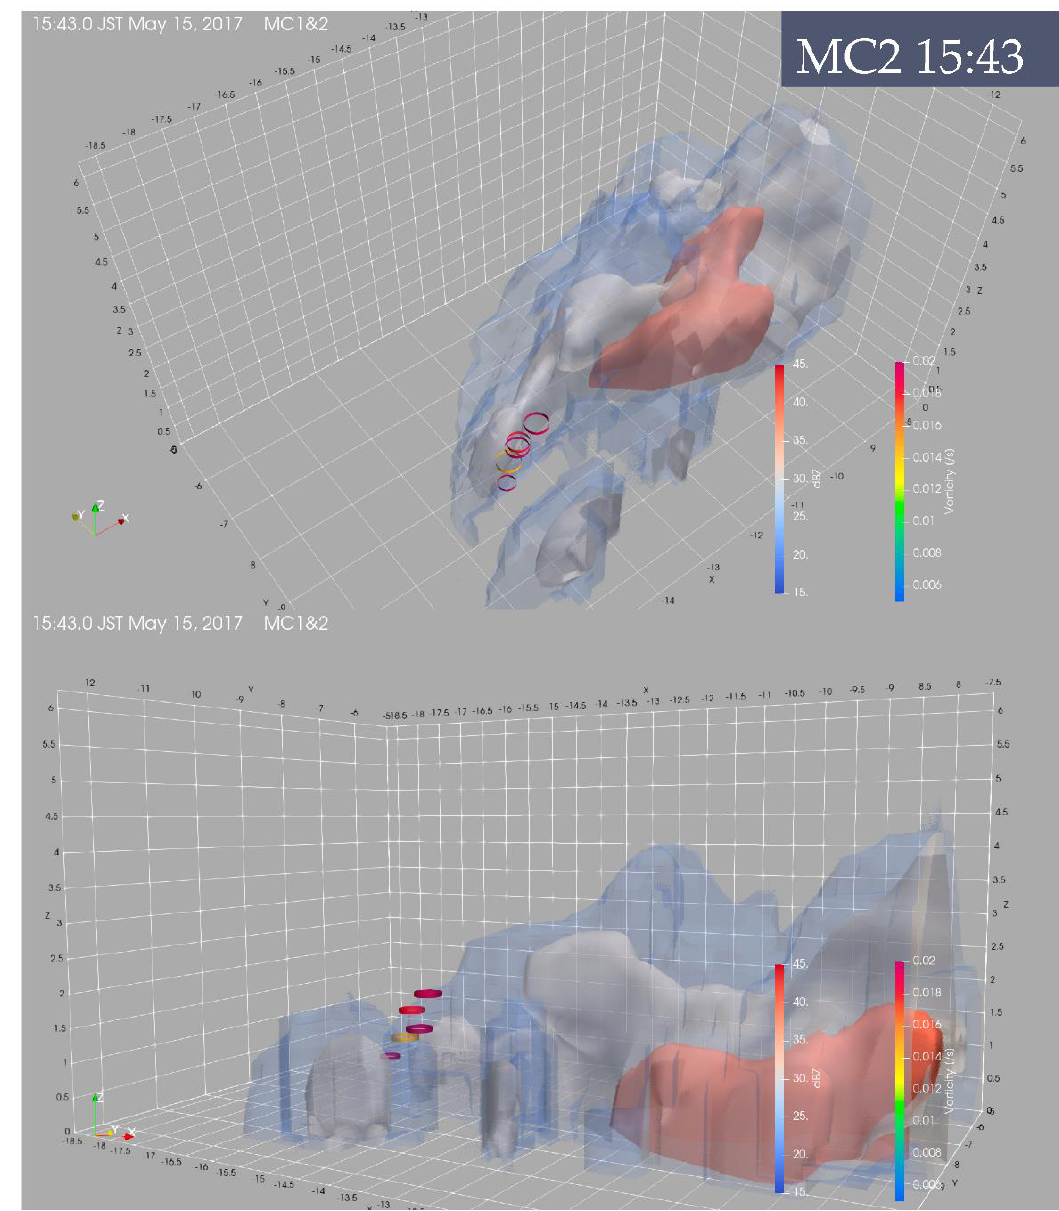
Figure 8. Same as Figure 4 except for 15:38 JST and 15:43 JST.